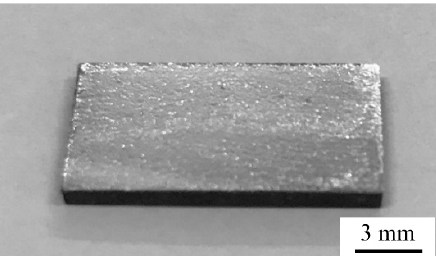
Figure 3. Photograph of 15 vol.% SiC p /6063 Al MMCs after Ga coating on bonding surface.